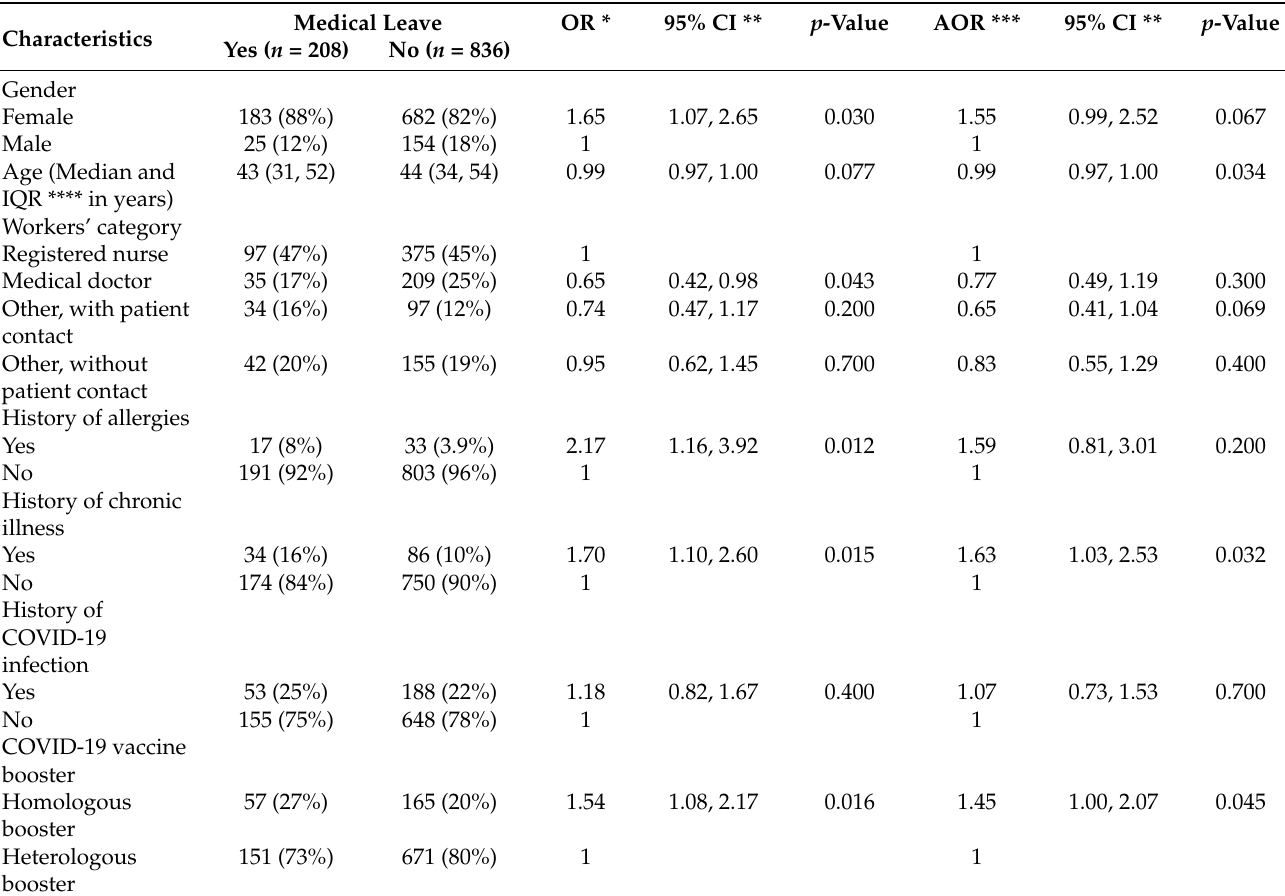
Table 4. The odds ratio of medical leave according to the sociodemographic characteristics and the medical history